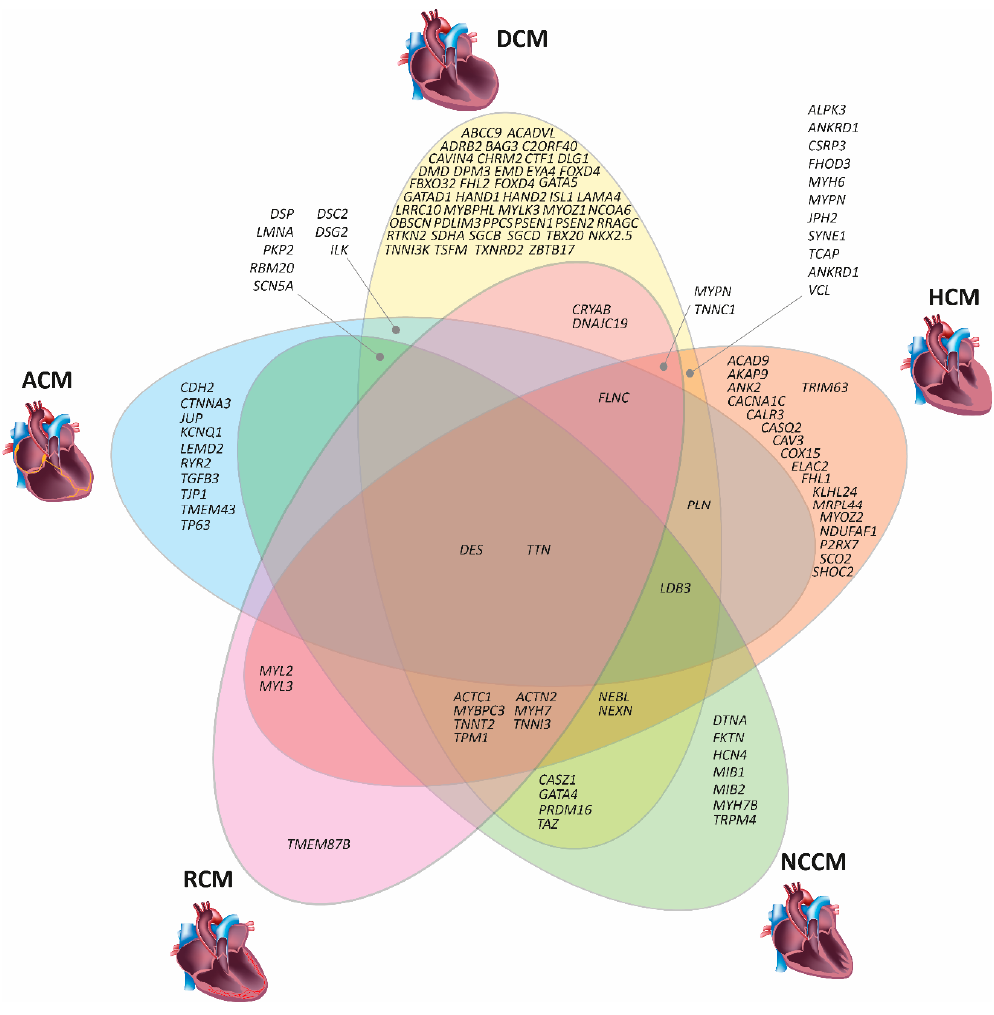
Figure 1. Schematic overview on cardiomyopathy associated genes and related clinical phenotypes. DCM—Dilated cardiomyopathy. HCM—Hypertrophic cardiomyopathy, ACM—Arrhythmogenic cardiomyopathy, NCCM—Non-compaction cardiomyopathy, RCM—Restrictive cardiomyopathy (Images of the DCM or HCM heart were licensed from shutterstock.com).